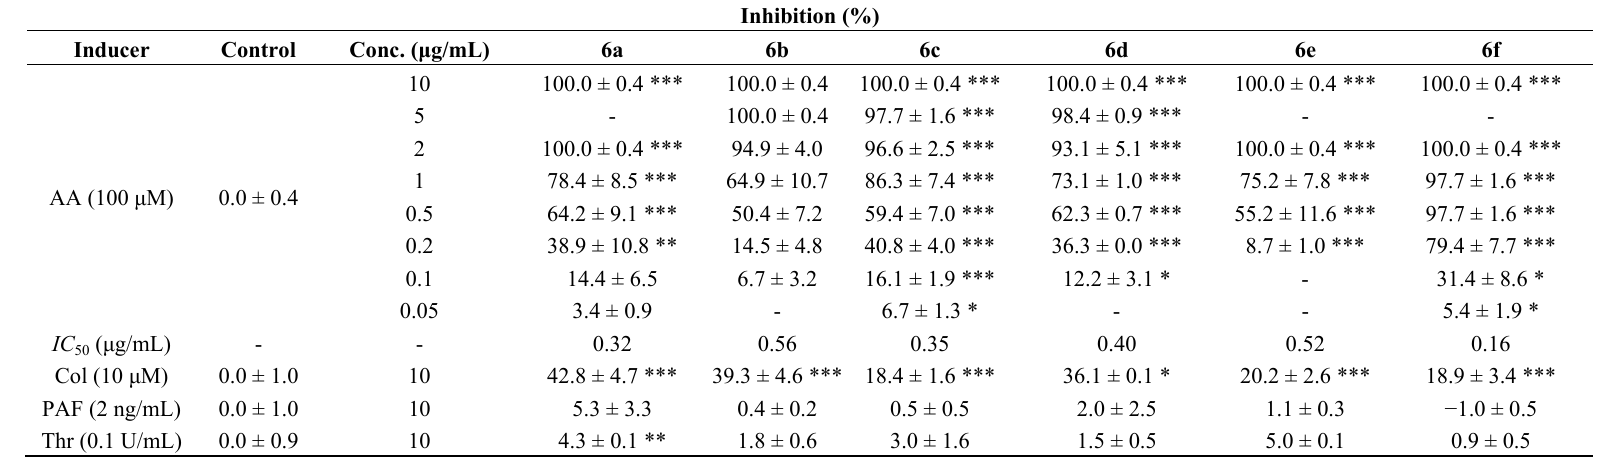
Table 7. Antiplatelet activity of [ n ]-dehydroparadols 6a – f